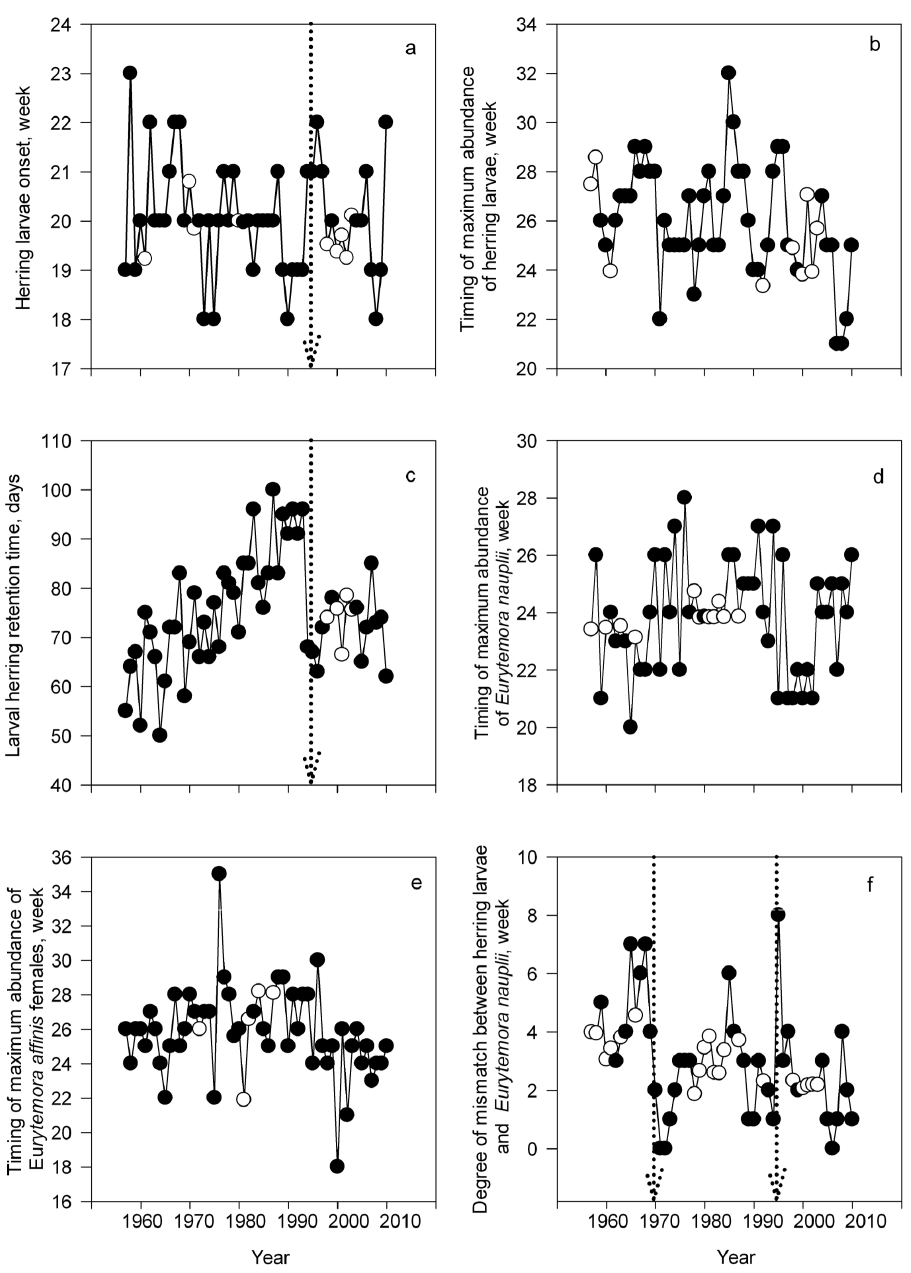
Figure 3. Long term dynamics of phenological variables as larval herring onset (a), timing of maximum abundance of herring larvae (b), larval herring retention time (c), timing of maximum abundance of Eurytemora affinis nauplii (d), timing of maximum abundance of Eurytemora affinis females (e), degree of mismatch between the timing of maximum abundance of herring larvae and Eurytemora affinis nauplii (f). Dotted lines indicate the position of the shift detected in single variables by shiftogram analyses. Empty dots denote the year when missing value replacement procedure was